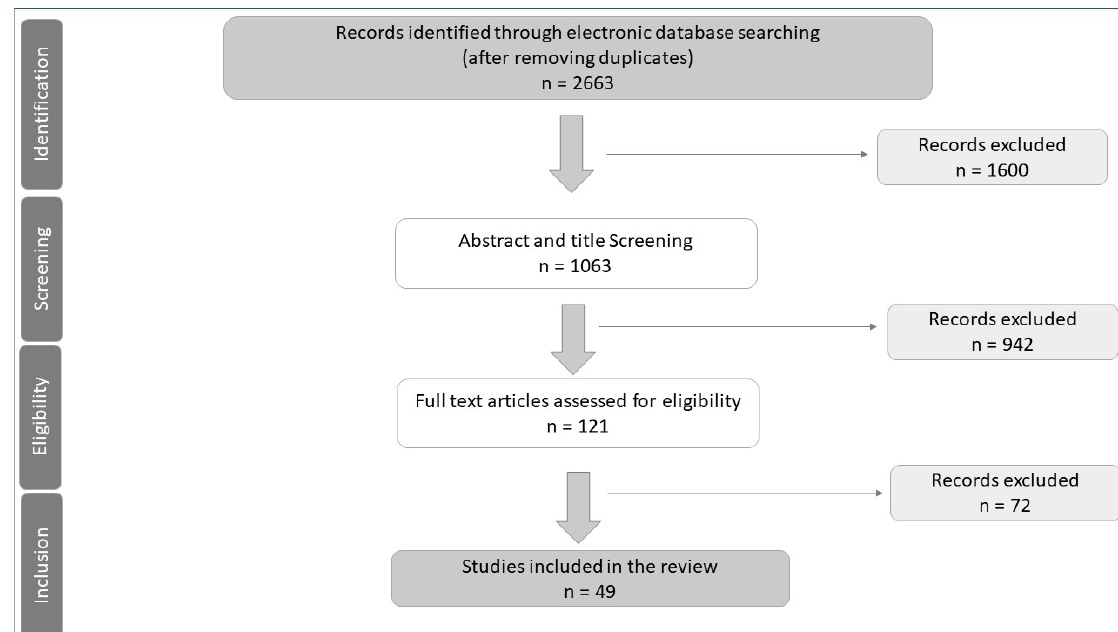
Figure 5. PRISMA Flow Chart.